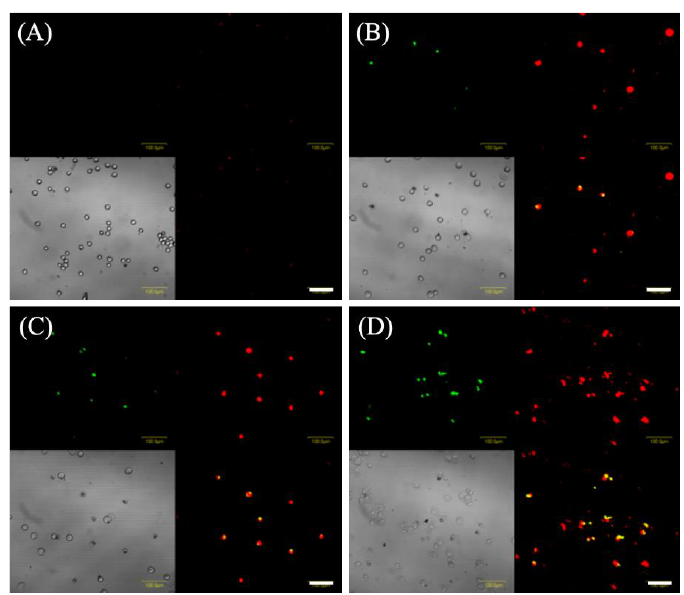
Figure 5. Fluorescent staining to detect cell death in EMT-6 cells. EMT-6 cells were incubated with 1 mM 5-aminolevulinic acid (5-ALA) for 4 h prior to washing and exposure to a 635-nm LED light. Cells were further incubated for 6 h before staining with annexin V (green) and ethidium homodimer III (red). Images represent the ( A ) control, ( B ) 5-ALA-PDT, ( C ) 5-ALA-PDT and artesunate, and ( D ) 5-ALA-PDT and artemether groups. Transmitted light images. Scale bar = 100 μm.